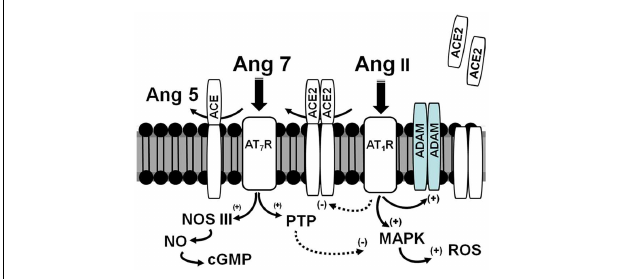
FIGURE 2 | Scheme for the interaction ofACE2 andADAMs on the apical surface of the proximal tubules in the diabetic kidney . Ang II binds to the AT 1 receptor (AT 1 R) and stimulates MAP kinase (MAPK) pathways and production of reactive oxygen species (ROS).The Ang II-AT 1 -receptor axis may attenuate ACE2 expression but increase ADAM levels. ACE2 is anchored to the apical membrane and directly converts Ang II to Ang-(1–7) (Ang 7); ACE also anchored to the membrane metabolizes Ang-(1–7) to Ang-(1–5) (Ang 5). Ang-(1–7) recognizes the AT 7 /Mas receptor (AT 7 R) to antagonize the actions of the Ang II-AT 1 R by stimulation of protein phosphatases (PTP) and nitric oxide synthase (NOS) to form nitric oxide (NO) and cGMP. In pathological conditions, increased expression of ADAMs may hydrolyze ACE2 away from the apical surface to increase local concentrations of Ang II and reduce the levels of